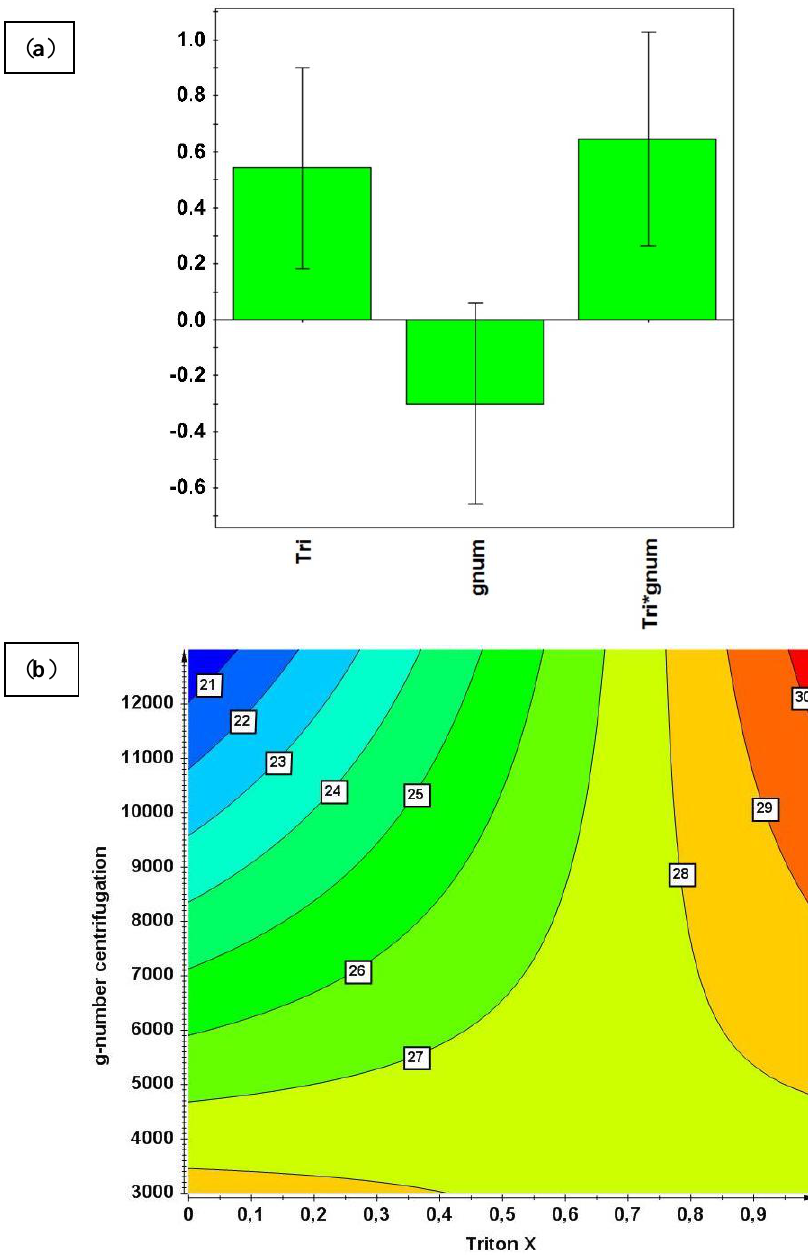
Figure 6. ( a ) Normalized coefficient plot for the significant factors Triton X-100 concentration (Tri) and g-number of centrifugation (gnum). ( b ) Prediction plot for IB purity. IB purity is shown as a function of Triton X-100 concentration in the washing step and g-number of the centrifugation